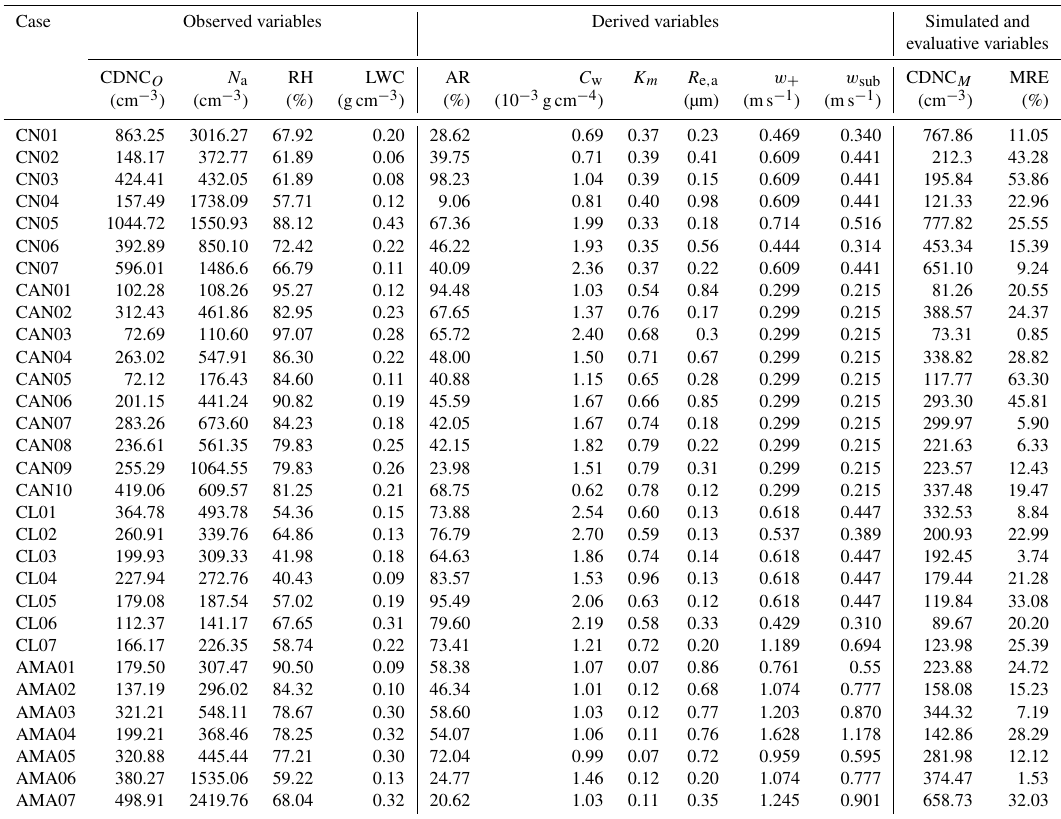
Table B2. A summary of observed (CDNC O , N a , RH, and LWC), derived (AR as mentioned in Sect. 4.1, C w as mentioned in Sect. 3.2.1, K m and R e , a as mentioned in Sect. 3.3, and w + and w sub as mentioned in Sect. 3.2.3), simulated, and evaluative (CDNC M and MRE) variables of each cloud case in four campaigns.